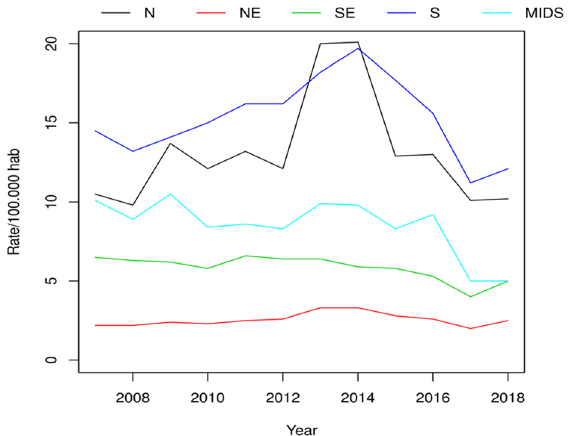
Figure 3. Hepatitis B infection rate per regions of Brazil from 2007 to 2018. The five regions of Brazil are represented as North (N), Northeast (NE), Midwest (MIDS), South (S) and southeast (SE). This figure was created by using the R software 19 version 3.5.3 (https:// www.R- proje ct.